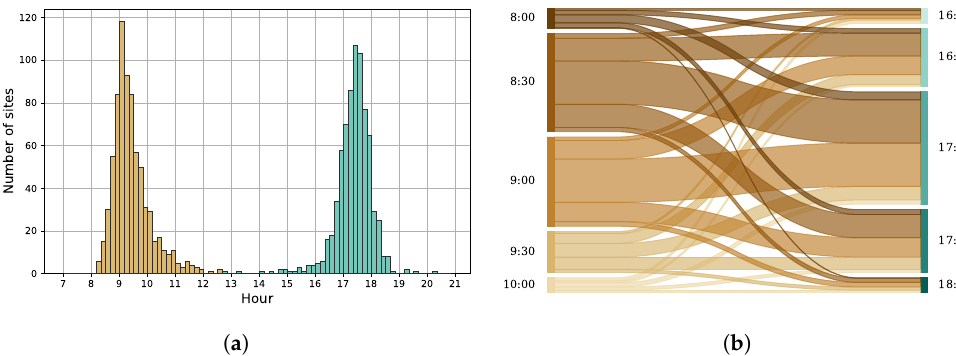
Figure 18. The distribution of the starting (brown) and the ending (green) of the working hours, in sites ( a ). The connection between the starting and the ending times ( b